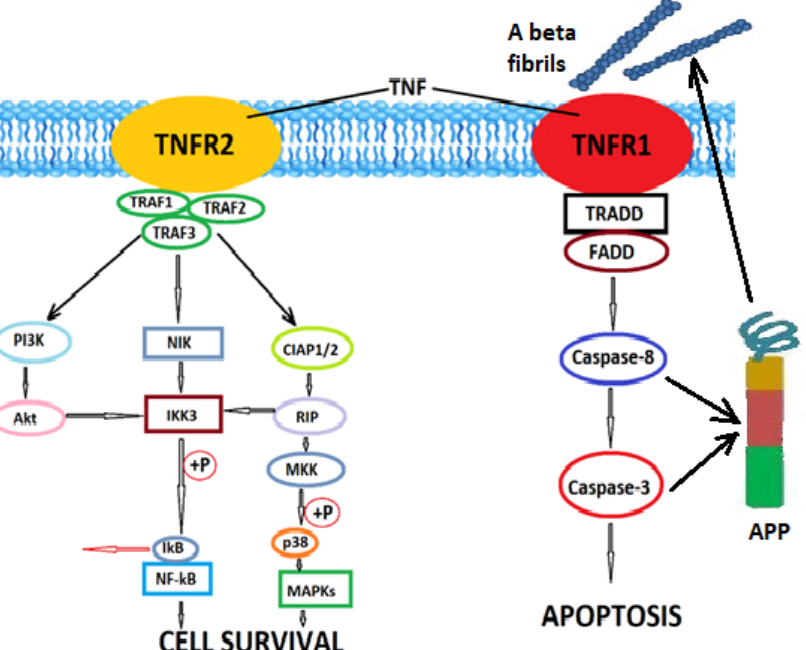
Figure 2. TNF signaling in Alzheimer’s disease. TNF receptor 1 (TNFR1) contains an intracellular TNF-receptor associated death domain (TRADD), which, upon TNF binding associates to FAS-associated death domain (FADD) and activates caspase 8 and caspase 3 leading to apoptosis. TNF receptor 2 (TNFR2) interacts with TNF receptor-associated factors (TRAF1, TRAF2, TRAF3) which interact with cellular inhibitor of apoptosis proteins 1 and 2 (CIAP1/2), NF- κ B-inducing kinase (NIK) and phosphoinositide 3-kinase (PI3K), promoting cell survival. Akt—serine-threonine kinase; I κ B—inhibitor of kappa B; IKK3—I κ B kinase 3; NF- κ B—nuclear factor kappa B; RIP—receptor interacting protein; MKK—mitogen-activated protein kinase; MAPKs—phosphorylated mitogen-activated kinases;. In AD, A β can physically interact with TNFR1 and promote neuronal death, while the caspases activated by TNFR1 signaling can cleave amyloid precursor protein (APP), increasing the A β load in a feed-forward loop.